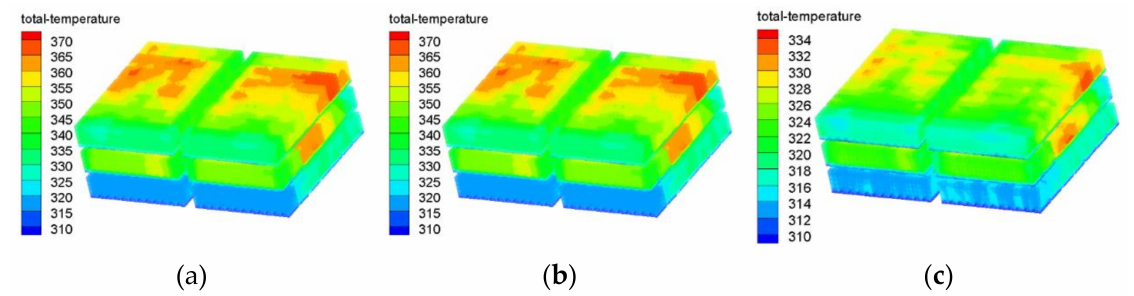
Figure 7. Temperature cloud diagrams for type I battery pack under different inlet wind speeds: ( a ) 1 m/s; ( b ) 2 m/s; and ( c ) 2